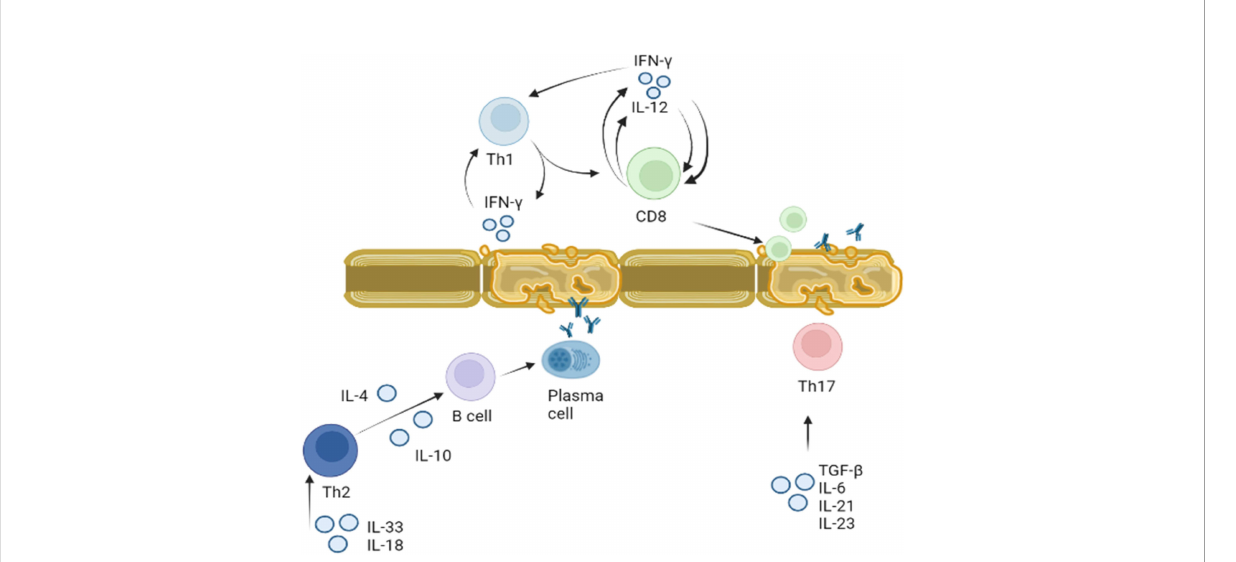
FIGURE 4 Role of cytokines in activation of T and B lymphocytes in MS. Activation of Th1 and Th2 lymphocytes was demonstrated in MS. Th1 lymphocyte differentiation is regulated by IFN- g . Once Th1 cells are activated they produce more IFN- g stimulating differentiation and proliferation of CD8 cells. CD8 cells also release IFN- g , which together with Il-12 supports CD8 and Th1 proliferation. Activated myelin primed activated CD8 lymphocytes could damage myelin sheets. Activated by IL-18 and IL-33, Th2 lymphocytes secrete IL-4 and IL-10 which support proliferation and differentiation of B cells. Myelin antigen primed B cells could terminally differentiate to plasma cells producing anti-BMP antibodies targeting myelin sheets. Th17 lymphocytes proliferation and differentiation is supported by IL-6, IL-21, IL-23 and TGF- b . These activated Th17 lymphocytes could also target axon myelin sheets and contribute to the local in fl